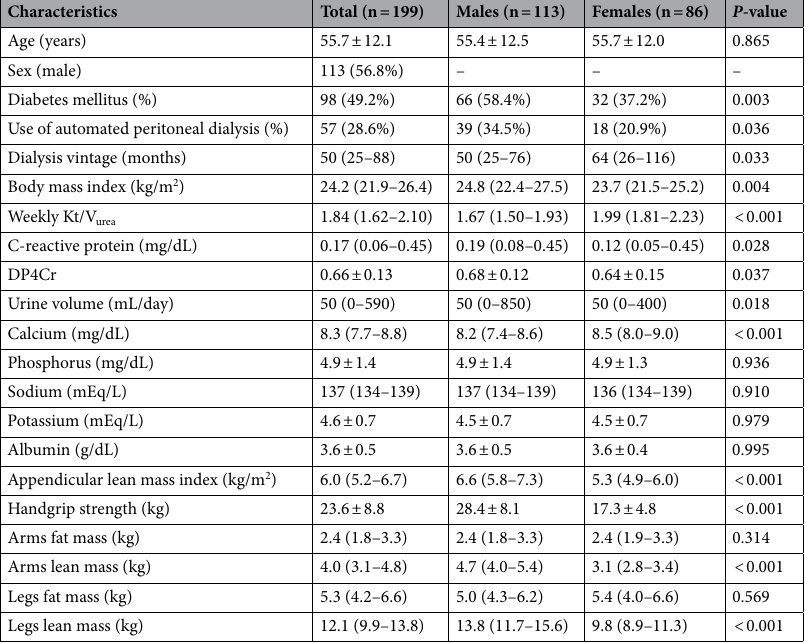
Table 1. Clinical characteristics of participants. Data are expressed as means ± standard deviations for continuous variables with normal distribution and as medians (interquartile ranges, 25th–75th) for those without normal distribution. Categorical variables are expressed as numbers (percentages). P -values were tested between males and females using Mann – Whitney U-test for continuous variables with non-normal distribution and t -test for those with normal distribution. Categorical data were compared using Pearson’s χ 2 or Fisher’s exact test. Abbreviations: DP4Cr, four-hour dialysate-to-plasma creatinine concentration ratio.